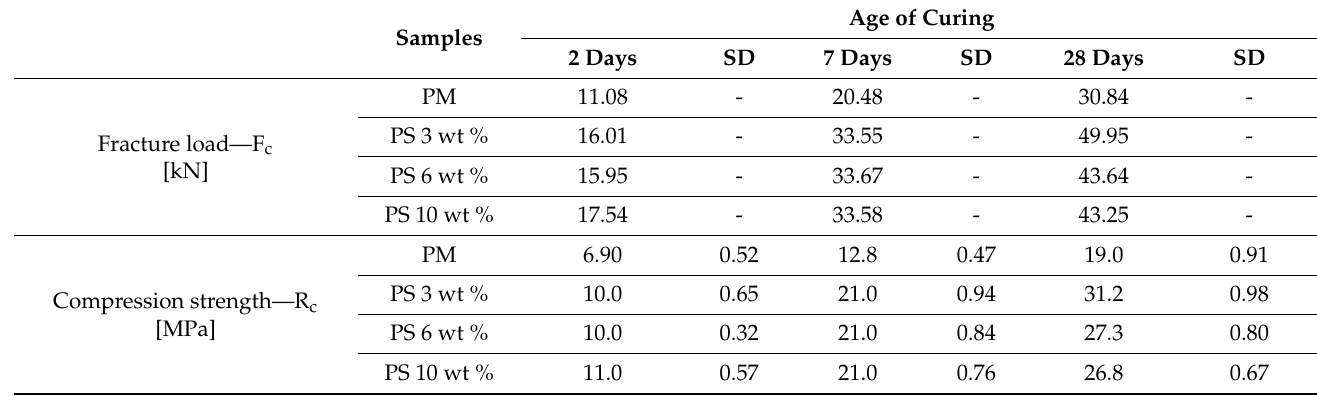
Table 2. Compression strength ( R c ), fracture load ( F f ), and the standard deviation (SD) results for the control sample